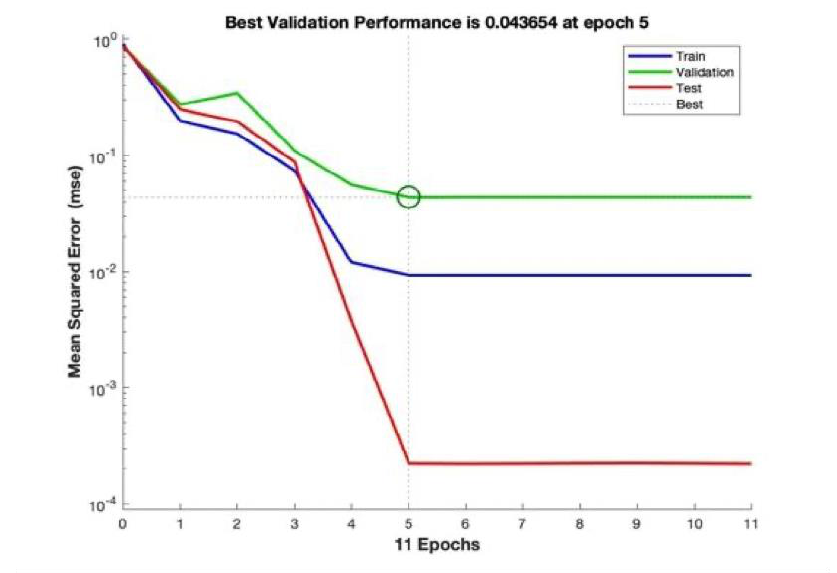
Figure 5: Classification Performance of SubB_6chan_3LRF RNN